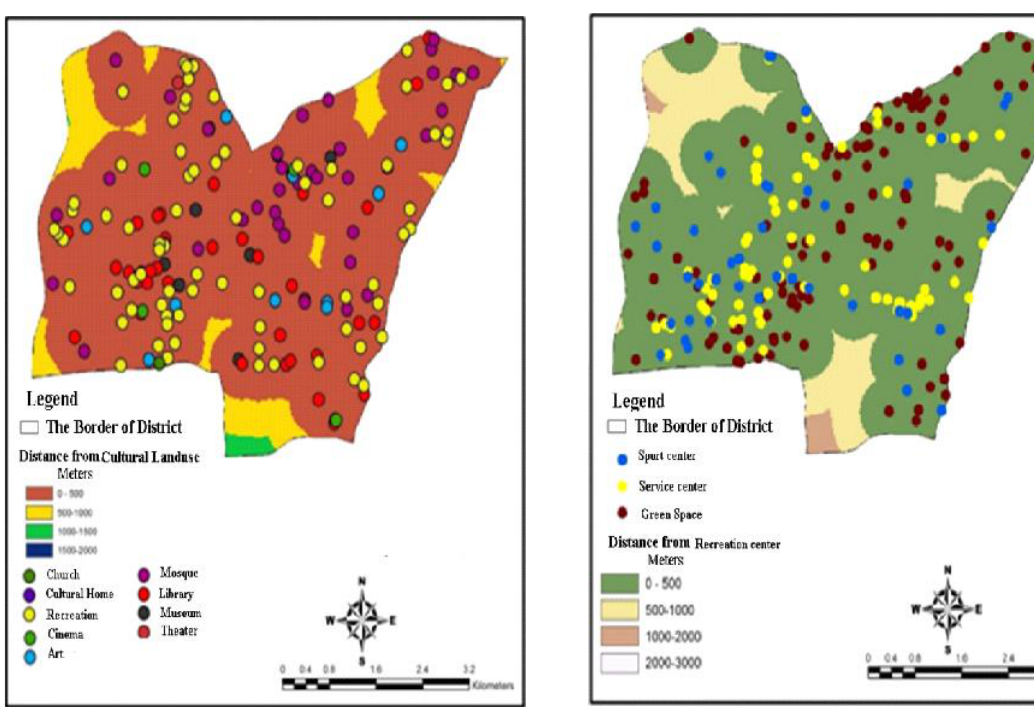
Fig. 14: The distance from Cultural Land use Fig.15: The distance from Recreation Land use